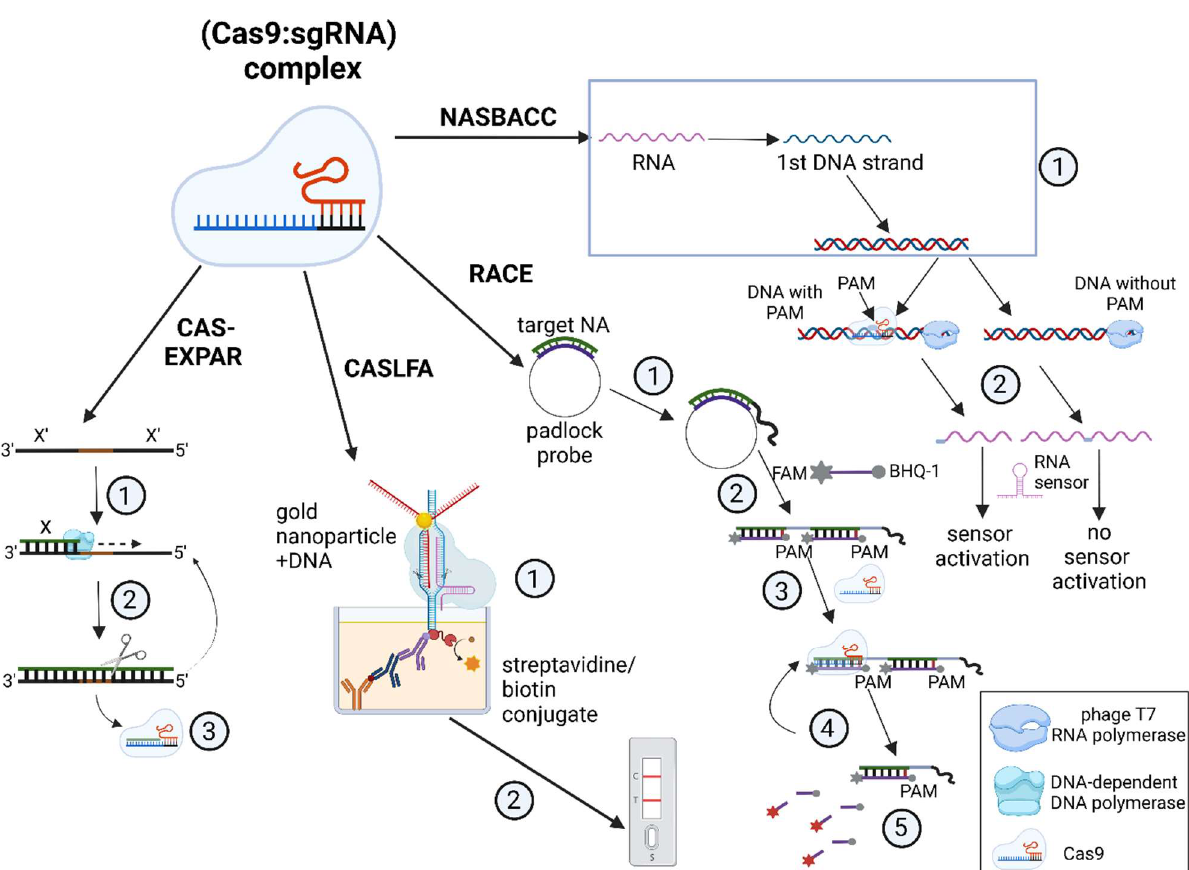
Figure 5. Nucleic acid detection methods using the Cas9 protein. Cas–EXPAR : (1) dsDNA synthesis combined with (2) its cleavage by a restriction enzyme; (3) Cas9-mediated interference. CASLFA :